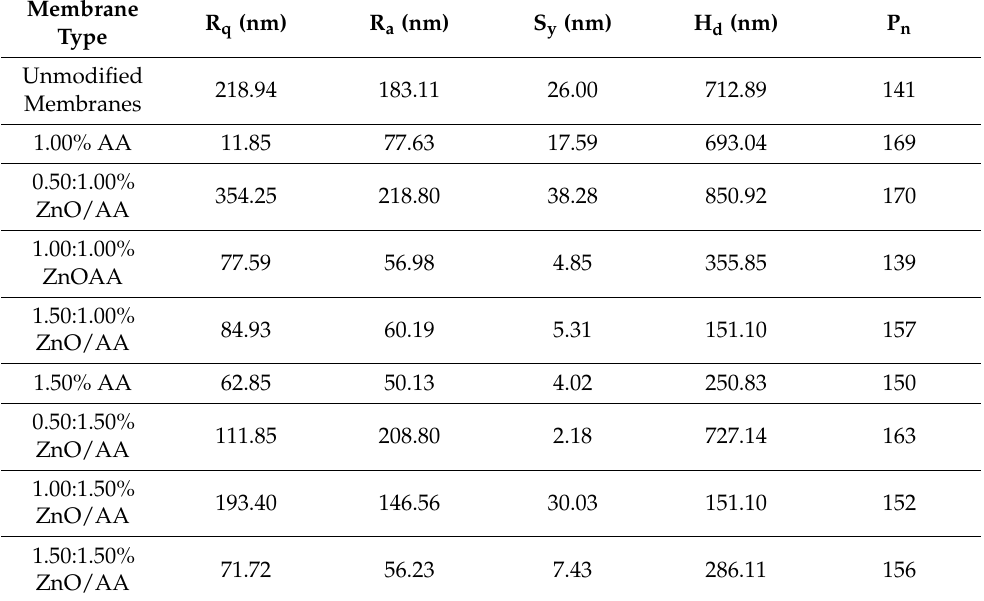
Table 2. Peak to peak maximum distance (S y ), height distribution (H d ), mean roughness (R a ), root mean square roughness (R q ), and peak densities (P n ) obtained from AFM analysis (image scan area; 20 × 20 µ